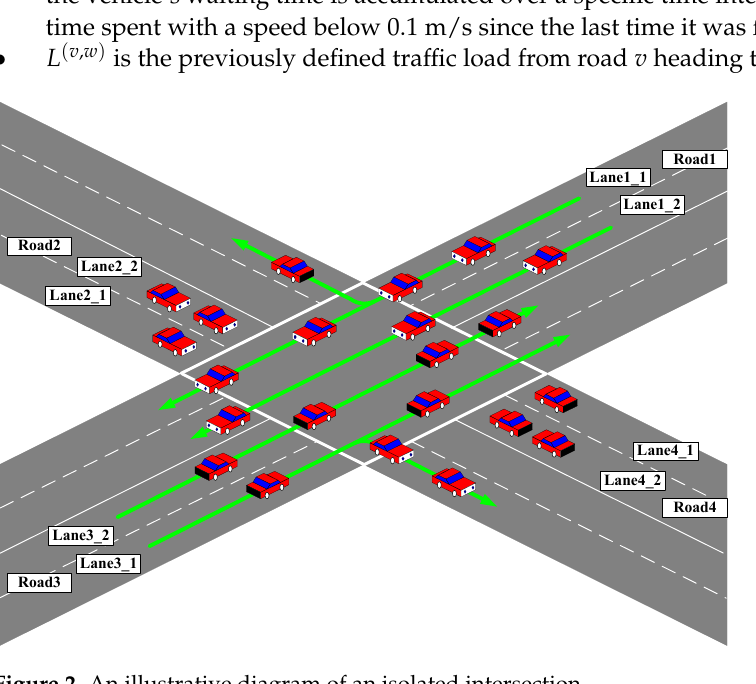
Figure 2. An illustrative diagram of an isolated intersection.